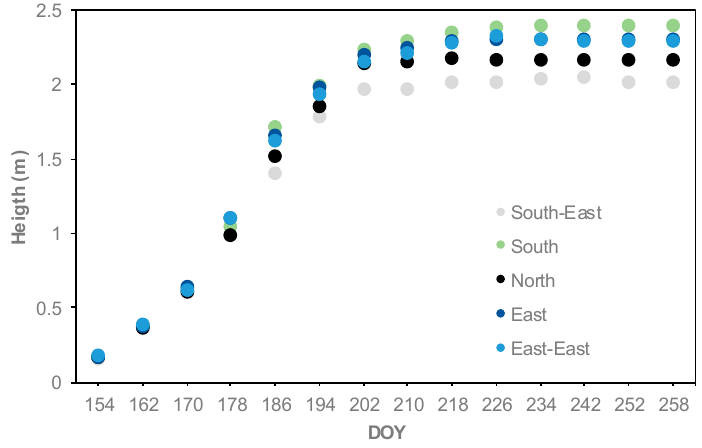
Figure 6. Seasonal progression of corn height at five observation locations throughout the 2016 growing season. Table 3. Comparison of LAI values estimated with the METRIC (MET) model and measured with AccuPAR (Accup) at five locations during the 2016 growing season, for assessing the LAI by the METRIC model.